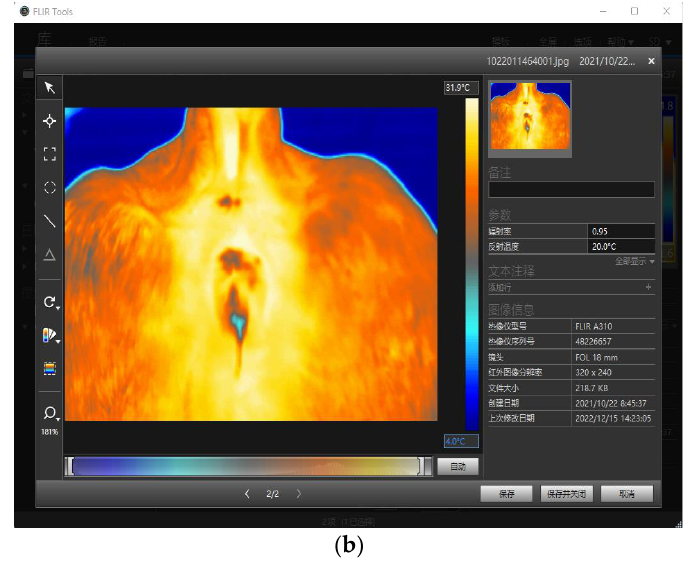
Figure 4. Comparison of thermal infrared images of dairy cows before and after normalization. ( a ) Comparison of cow’s head before and after normalization treatment ; ( b ) comparison of cow’s vulva before and after normalization treatment. “ 备注 ” means Remarks ; “ 参数 ” means Parameters; “ 辐射率 ” means Irradiance; “ 反射温度 ” means Reflection temperature; “ 全部显示 ” means Show all; “ 文本注释 ” means Text notes; “ 添加行 ” means Add lines; “ 图像信息 ” means Image information; “ 热像仪型号 ” means Thermal imager model; “ 热像仪序列号 ” means Serial number of thermal imager; “ 镜头 ” means Lens parameter; “ 红外图像分辨率 ” means Infrared image resolution; “ 文件大小 ” means File size; “ 创建日期 ” means Creation date; “ 上次修改时间 ” means Last modification time ； “ 自动 ” means Auto; “ 保存 ” means save; “ 保存并关闭 ” means save & close; “ 取消 ” means cancel.